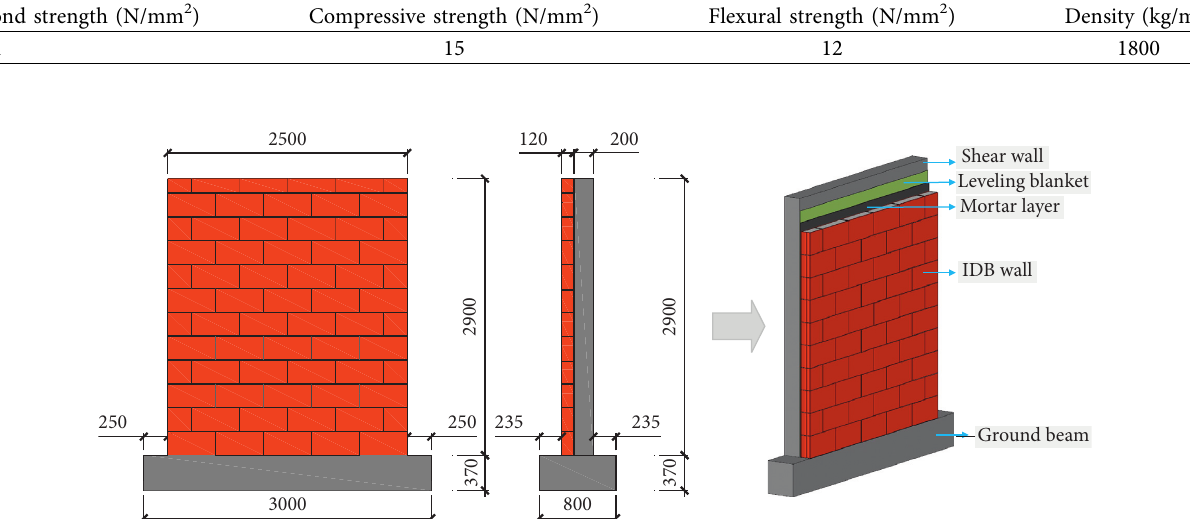
Figure 2: Introduction of IDB. (a) Components of IDB. (b) Dimensions of IDB. Table 1: Performance parameters of mortar.